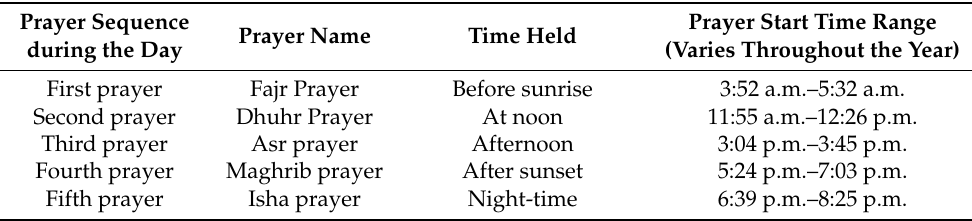
Table 2. Daily prayer times in Muscat, Oman [24].